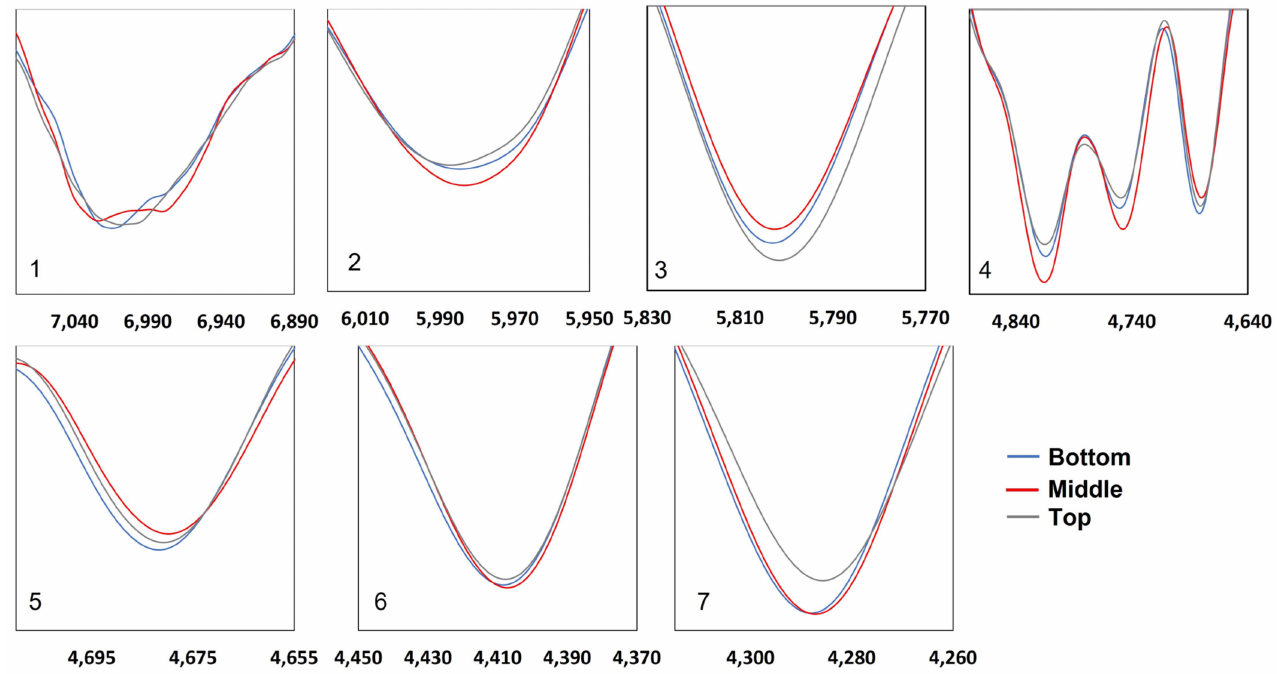
Figure 14. Enlarged bands at specific regions of second derivative spectra: ( 1 ) bands 7000 cm − 1 assigned to an amorphous region of cellulose; ( 2 ) bands 5980 cm − 1 assigned to aromatic skeletal due to lignin; ( 3 ) bands 5800 cm − 1 assigned to furanose or pyranose due to hemicellulose; ( 4 ) bands 4890–4,620 cm − 1 assigned to cellulose region; ( 5 ) bands 4686 cm − 1 assigned to lignin or extractives; ( 6 ) bands 4404 cm − 1 assigned cellulose and hemicellulose; and ( 7 ) bands 4283 cm − 1 assigned to cellulose, hemicellulose, and